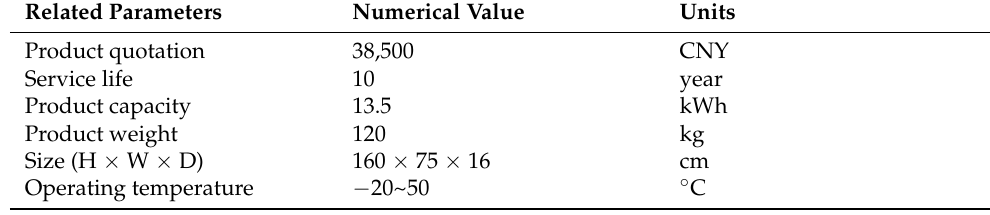
Table 12. Relevant parameters of household energy storage products produced by Enterprise X.